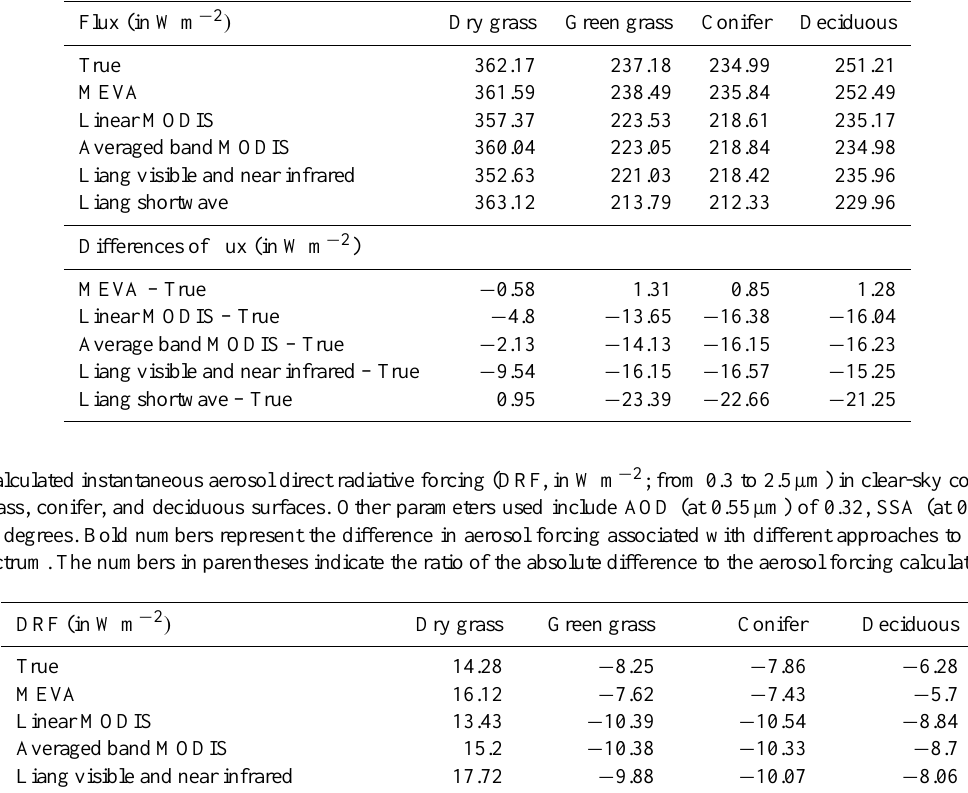
Table 1. The calculated outgoing solar flux (in Wm − 2 ; from 0.3 to 2.5µm) at TOA over dry grass, green grass, conifer, and deciduous surfaces. Other parameters used include AOD (at 0.55µm) of 0.32, SSA (at 0.55µm) of 0.89, and SZA of 30 degrees. Bold numbers represent the difference in flux associated with different approaches to estimate the surface reflectance spectrum.